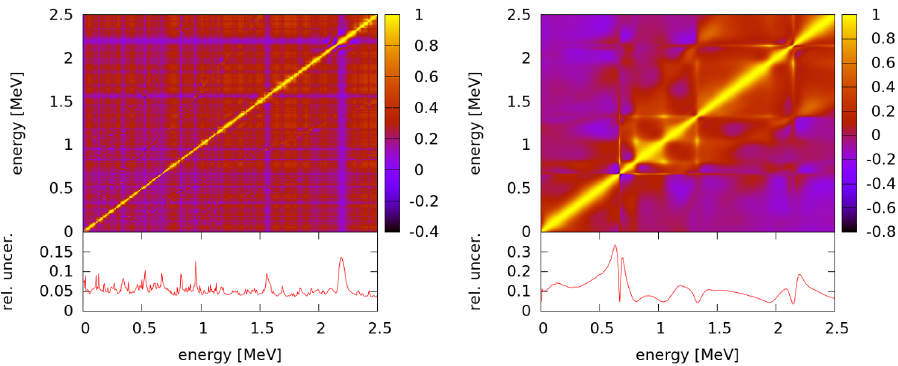
√ K 1 ( E i , E i ) /σ true